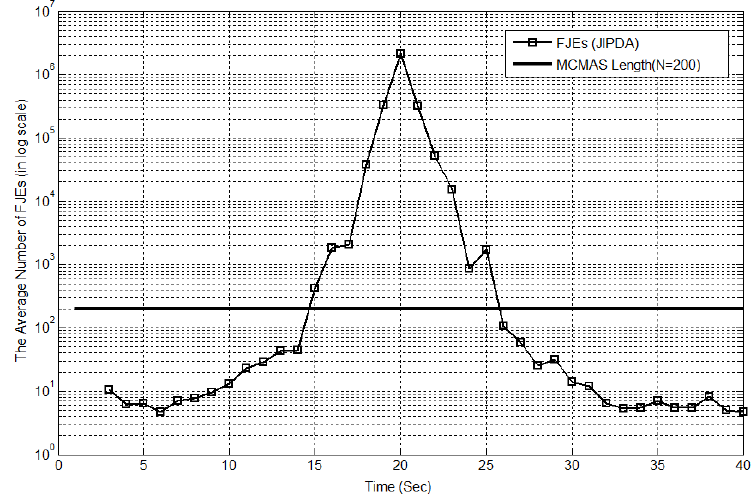
Figure 4. The average number of feasible joint events (FJEs) of joint integrated probabilistic data association (JIPDA) for Case #1.